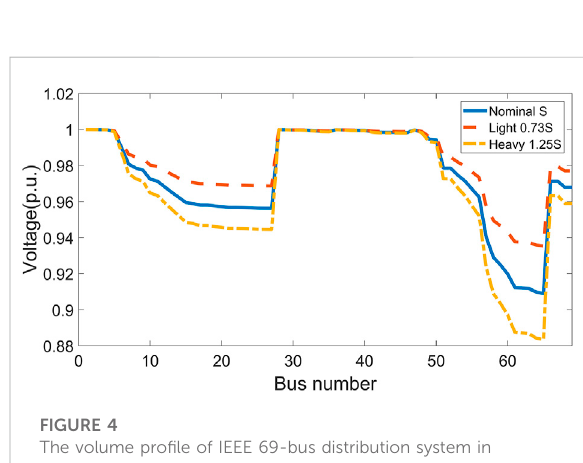
FIGURE 4 The volume pro fi le of IEEE 69-bus distribution system in scenario